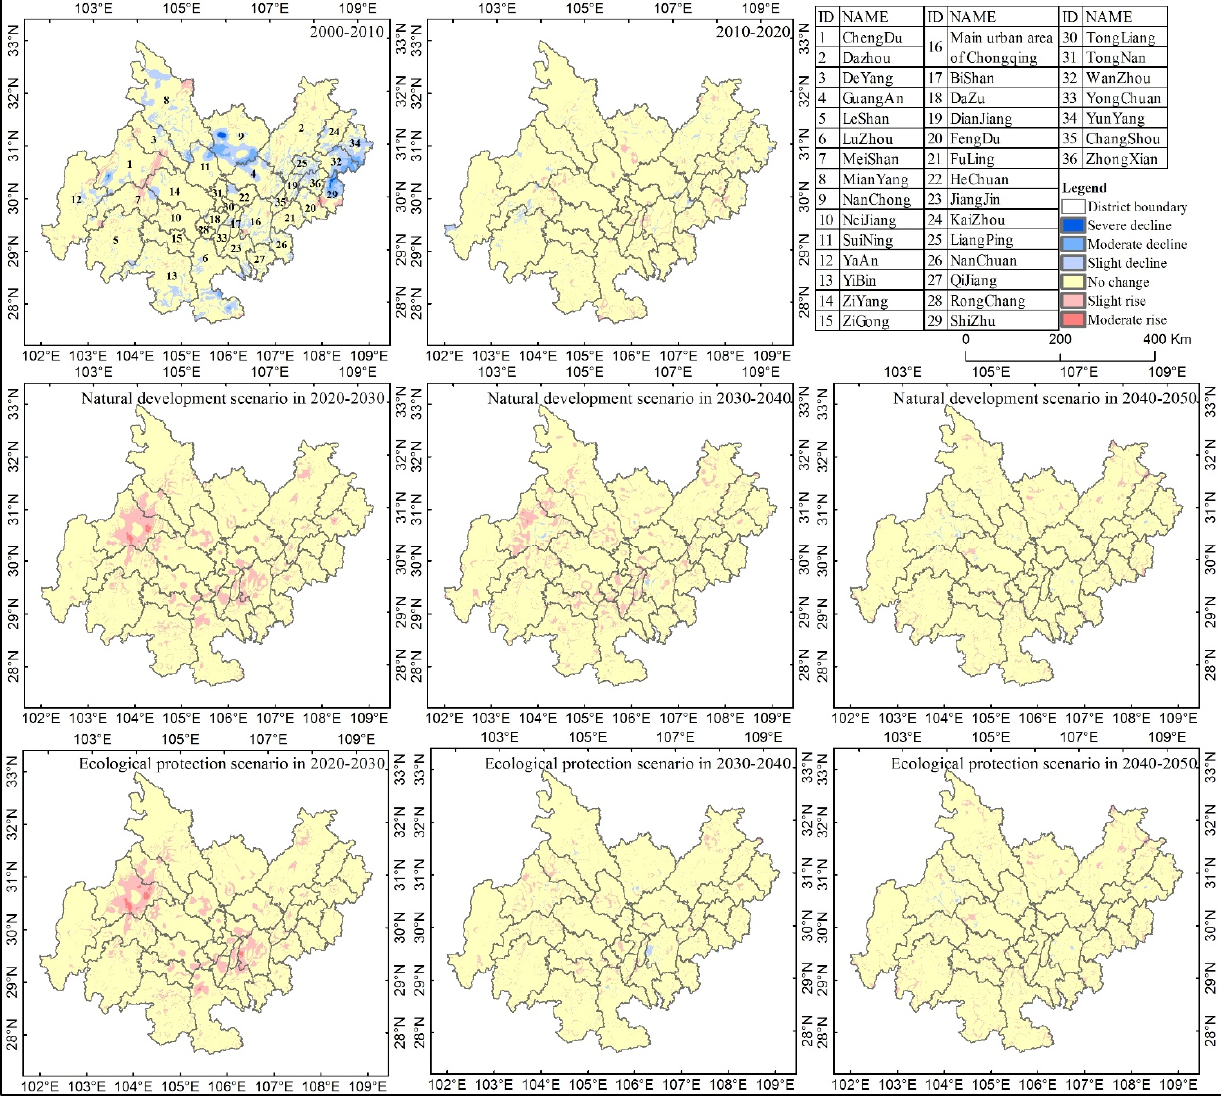
Figure 5. Evolution distribution of the LER level at the grid scale.